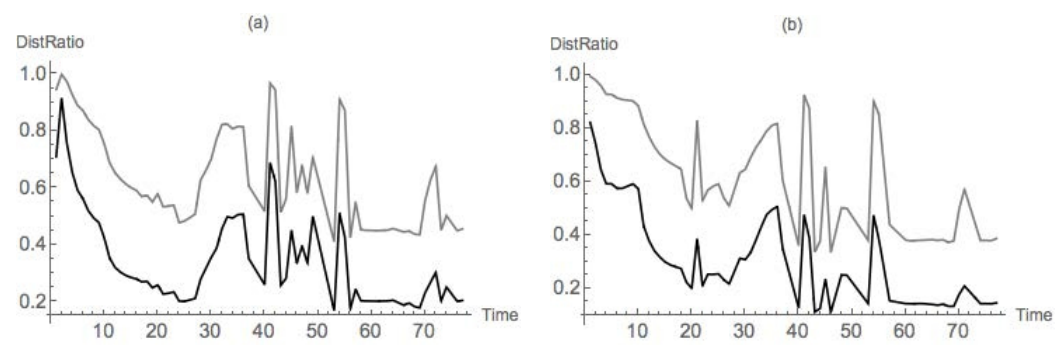
Figure 6. β 0 : Interpolation functions of ratios of bottleneck distance to Wasserstein-1 distance (black dots) and Wasserstein-2 distance (gray dots) for ( a ) N θ = 15 and ( b ) N θ =